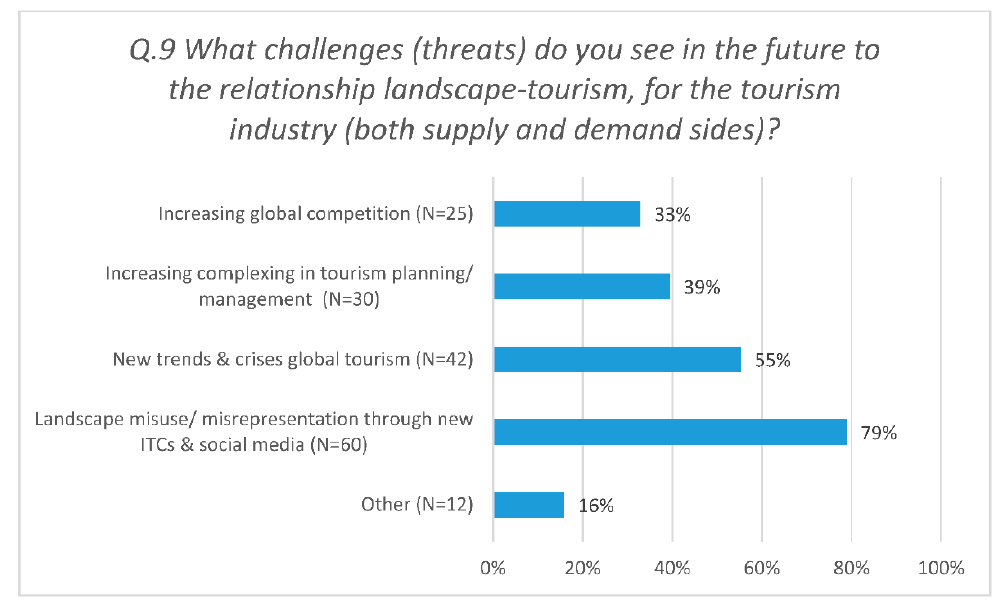
Figure 7. Challenges of the tourism–landscape relationship for the tourism industry.